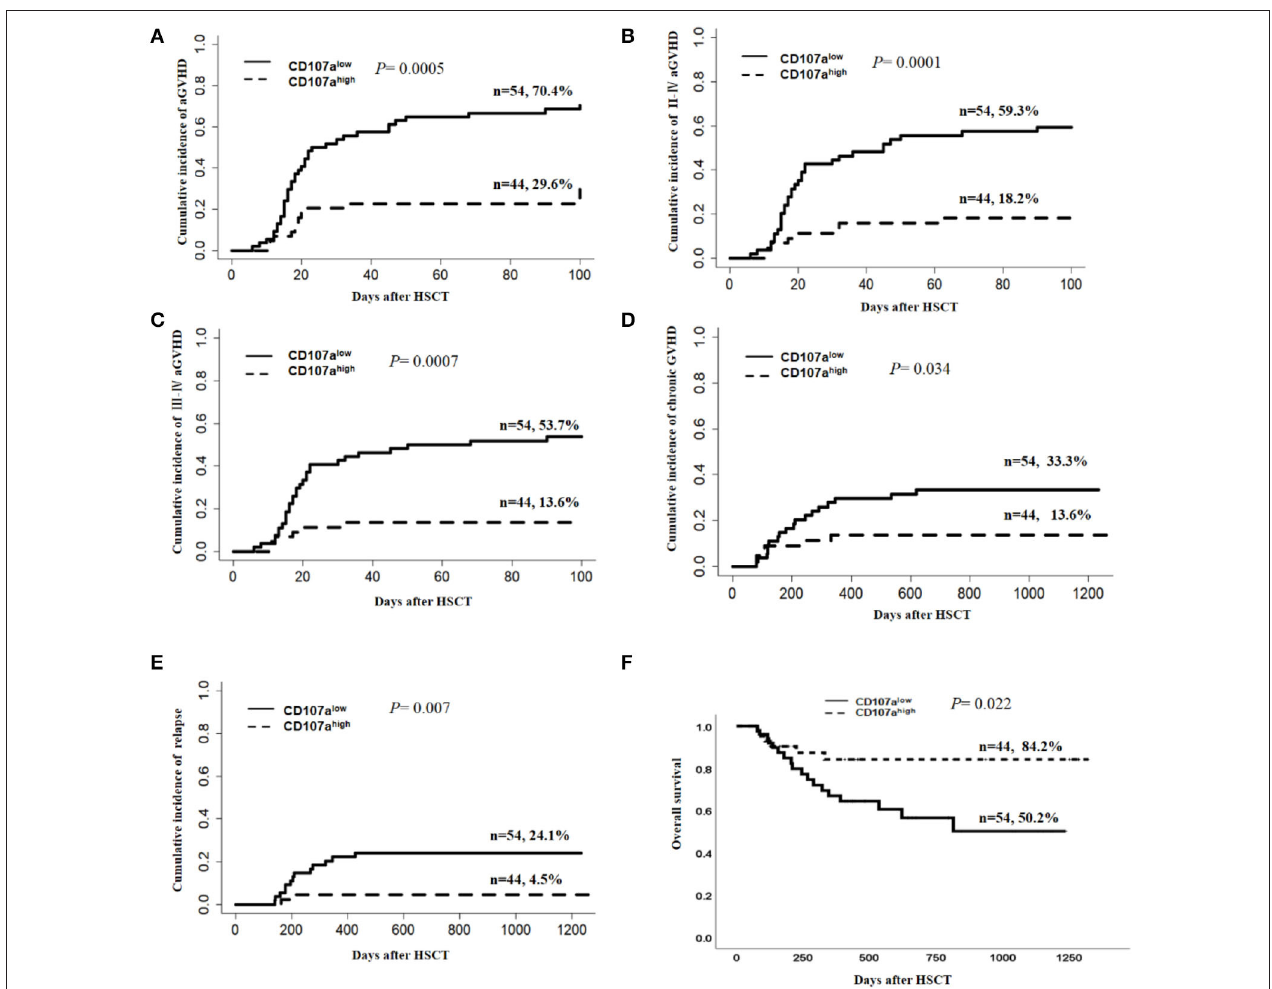
FIGURE 3 | Donor NK CD107a degranulation toward activated T cells was predictive for risk of aGVHD, chronic GVHD, relapse, and overall survival. The Gray’s test was applied for comparisons of cumulative incidences of acute GVHD, chronic GVHD, and relapse. Death, without aGVHD, was defined as the competing event for aGVHD, while relapse-free mortality was the competing event for relapse. Cumulative incidence estimates of grade I–IV aGVHD (A) , gradeII–IV aGVHD (B) , grade III–IV aGVHD (C) , chronic GVHD (D) , and relapse (E) or Kaplan–Meier survival estimates for overall survival (F) for patients in “CD107a low ” and “CD107a high ” groups, separated according to the optimal cutoff of 20.5% for donor NK CD107a degranulation toward activated T